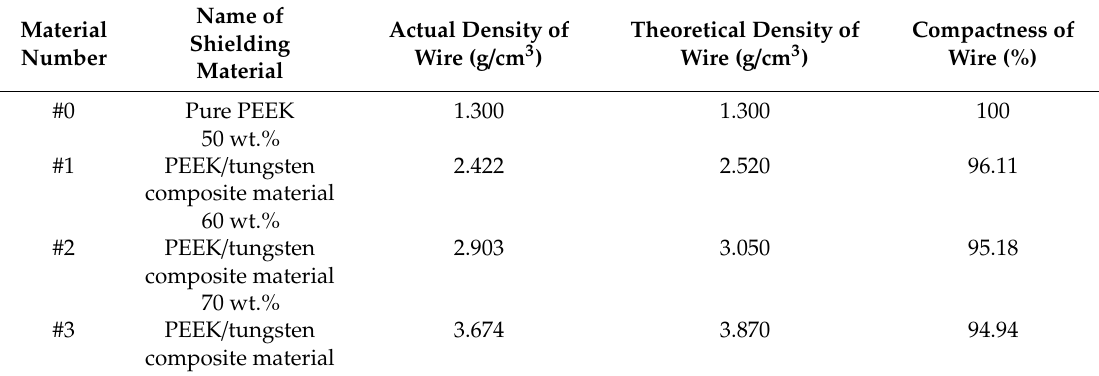
Table 2. The compactness values of PEEK and PEEK composites.